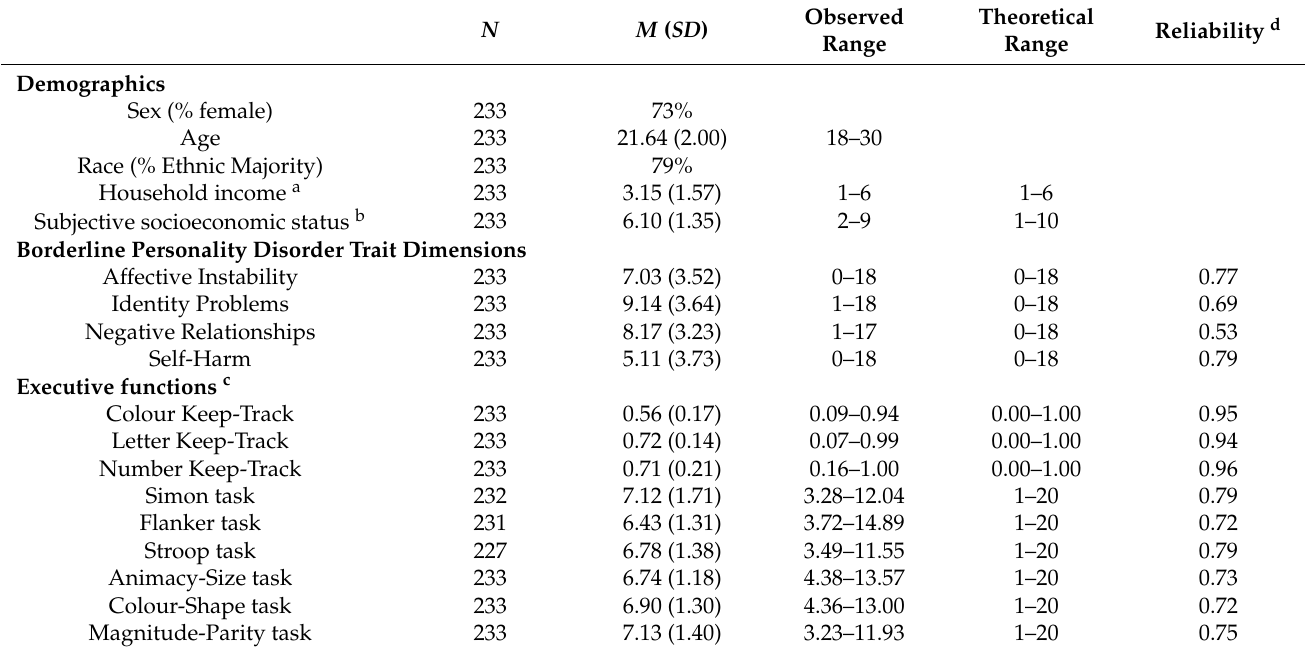
Table 1. Descriptive statistics of the